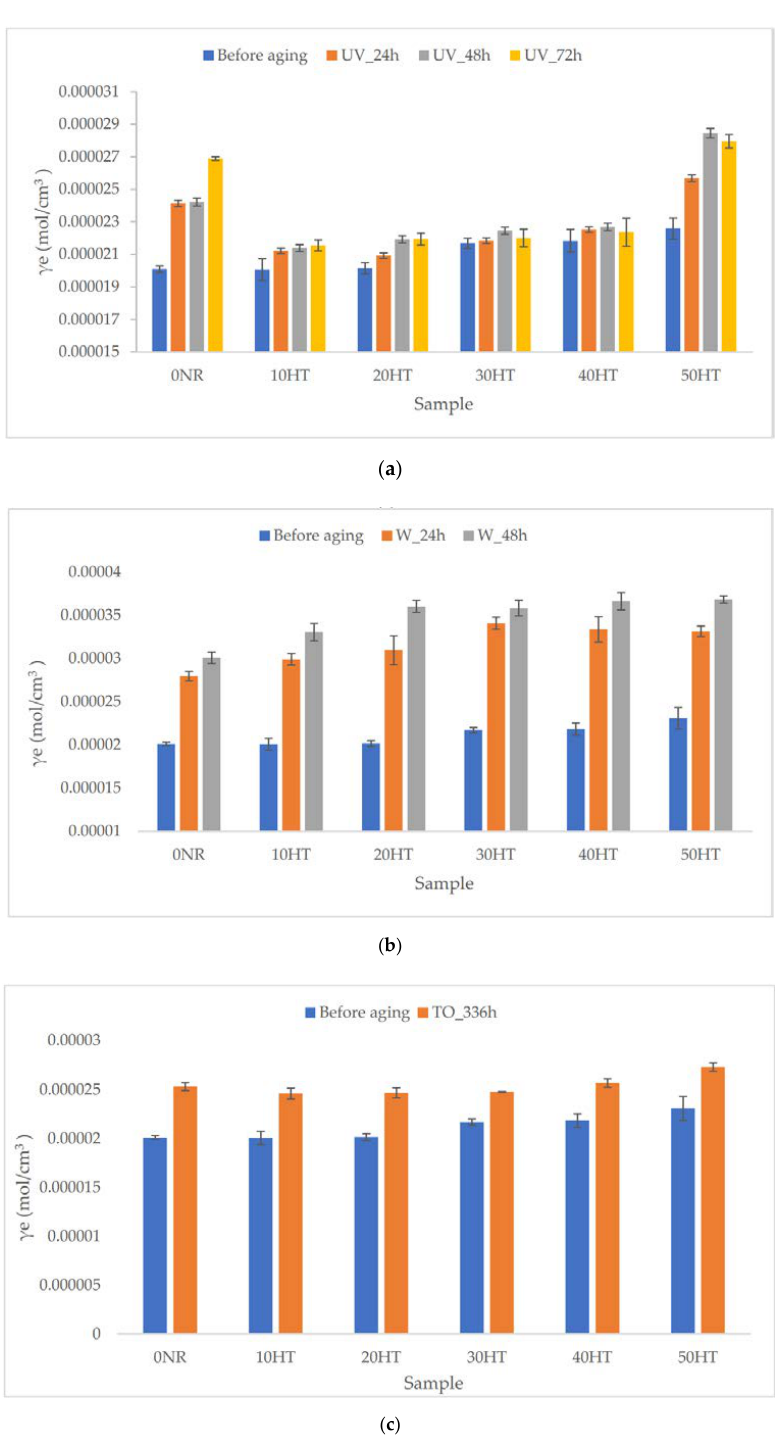
Figure 9. The crosslinking density of vulcanizates before and after simulated aging processes ( a ) UV, ( b ) weather, ( c ) thermo-oxidative.